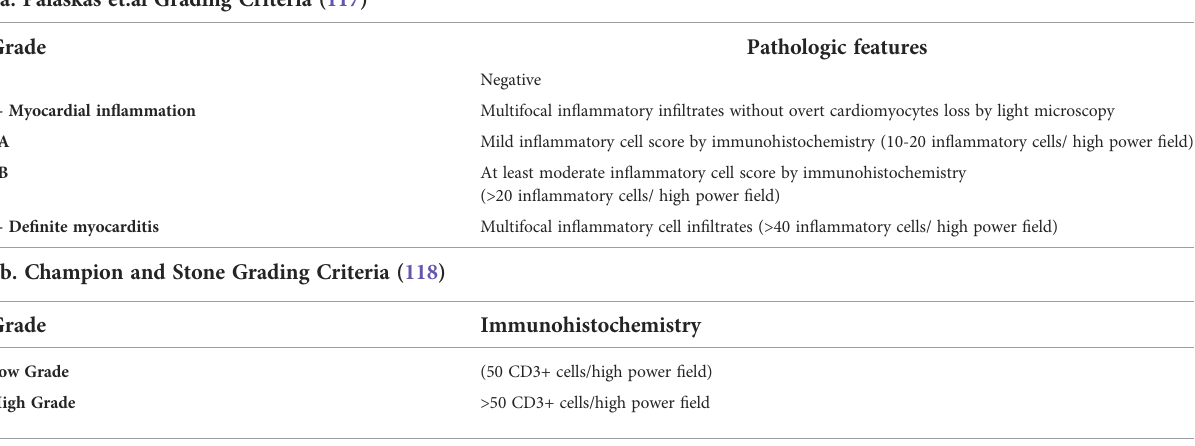
TABLE 3 Current Pathology Grading criteria for ICI induced myocardial in fl